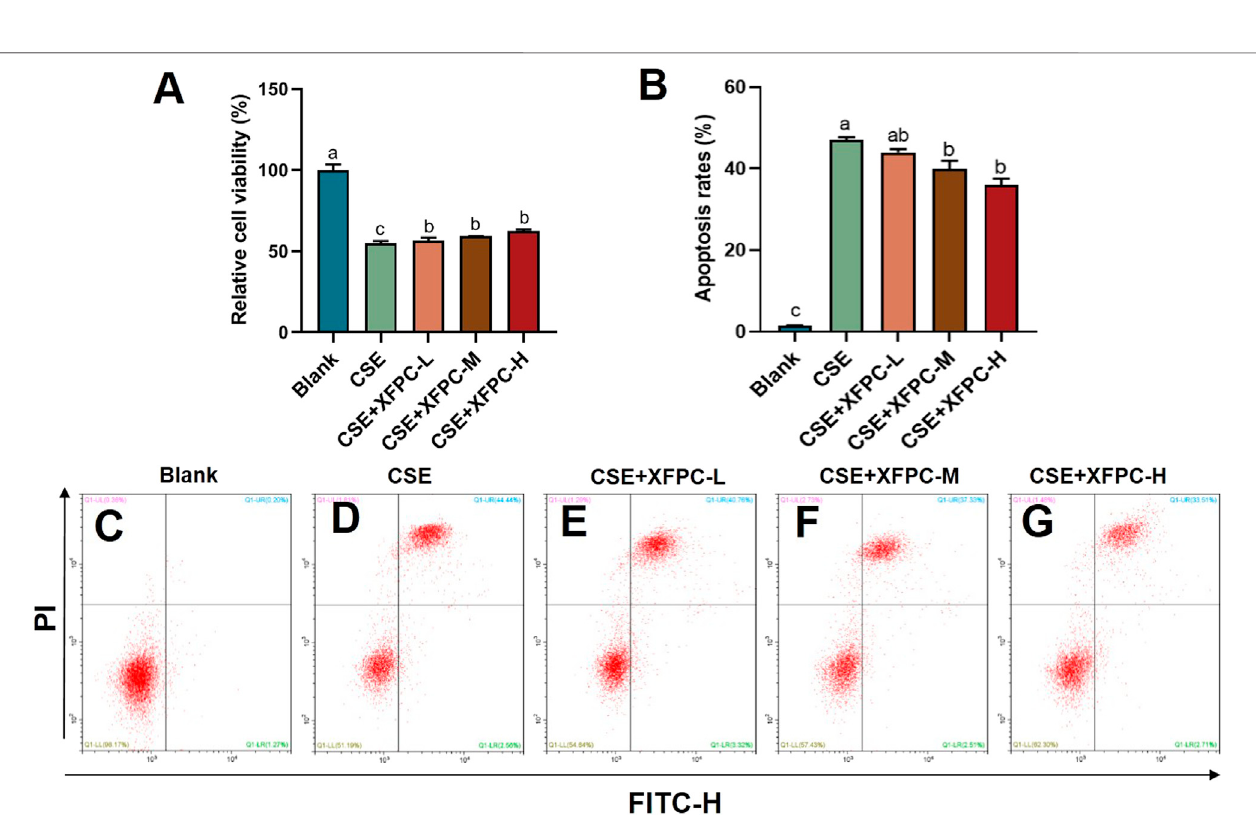
FIGURE 1 | XFPC could improve the cell survival rate and inhibit the apoptosis in CSE-HBE cells model. (A) Effects of different concentrations of XFPC on cell viability in CSE-exposed HBE cells. (B) The apoptosis rates of HBE cells in different group in panels (C – G) . (C – G) CSE-exposed HBE cells were treated with different concentrationsofXFPCorablankgroup.Apoptosiswasanalyzedby fl owcytometryafterAnnexinV/PIdoublestaining.Valuesarepresentedasmean ± SD.Lowercase lettersindicatestatisticallysigni fi cantdifferences( p < 0.05)accordingtoANOVAfollowedbyTukey ’ sHSDtest.XFPC, XuanfeiPingchuanCapsules;CSE,cigarette smoke extract; HBE cells, human bronchial epithelial